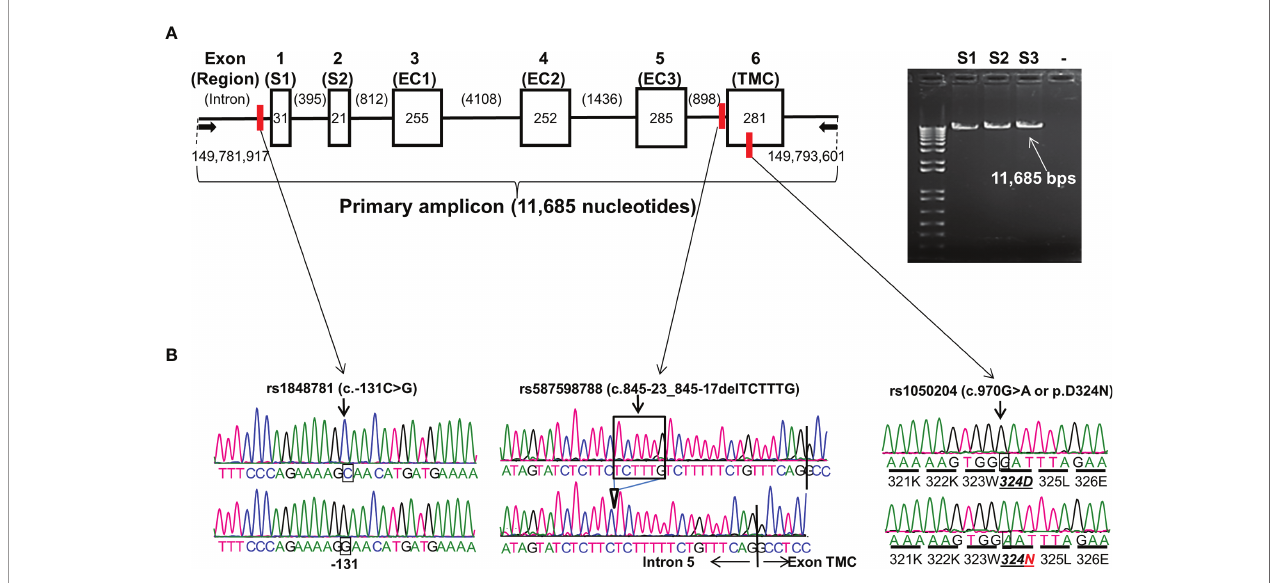
FIGURE 1 | FCGR1A gene structure and variants. (A) FCGR1A gene (NC_000001.11 Chromosome 1 Reference GRCh38.p13 Primary Assembly 149,782,694..149,791,675) at Chromosome 1q21.2 contains 6 exons encoding a protein peptide of 374 amino acids. Arrows indicate the positions of upper primer (starting at nucleotide position 149,781,917 on Chromosome 1 GRCh38.p13 Primary Assembly) and lower primer (ending at nucleotide position 149,793,601 on Chromosome 1 GRCh38.p13 Primary Assembly) in FCGR1A PCR ampli fi cation. Six boxes ( ▯ ) represent six exons with their respective nucleotide coding sequence lengths in bps. Five introns ( — ) with their nucleotide sizes in bps are shown schematically. The primary PCR amplicon of 11,685 nucleotides covered 1,125-nucleotide coding sequence, 51-nucleotide 5 ′ -UTR, and 159-nucleotide 3 ′ -UTR of FCGR1A . The red vertical bars indicate the positions of the three FCGR1A variants. S1 and S2 are two exon encoding the Fc g RIA signal peptide. Fc g RIA extracellular domain 1 (EC1), 2 (EC2), and 3 (EC3) are coded by the exon 3, 4, and 5, respectfully. The exon 6 codes for the Fc g RIA transmembrane segment and cytoplasmic domain (TMC). (B) Sequence tracers of three FCGR1A variants. Arrows indicate locations of SNV rs1848781 (c.-131C>G), rs587598788 (c.845-23_845-17delTCTTTG) indel variant, and SNV rs1050204 (c.970G>A or p.D324N) on sequence